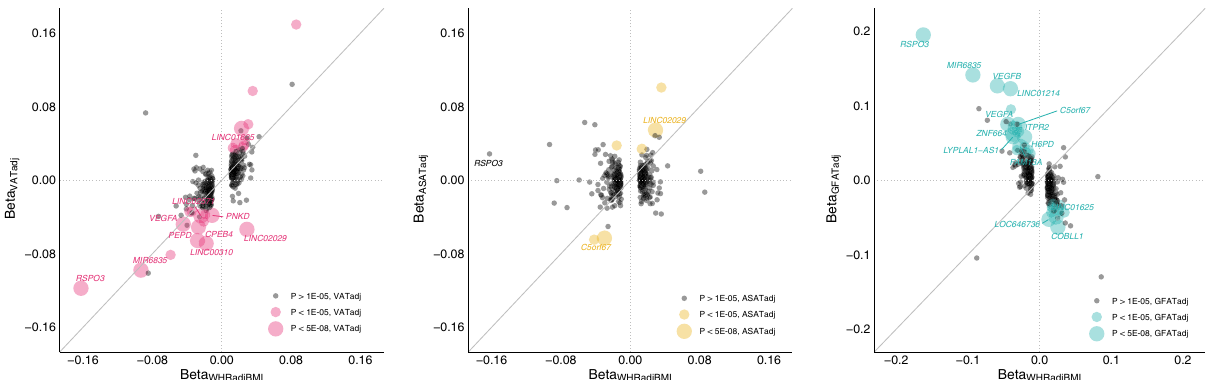
Fig. 4 Effects of previously identi fi ed WHRadjBMI loci on local adiposity traits. In total, 345 of the 346 index SNPs associated with WHRadjBMI in a recent meta-analysis from the GIANT consortium were available in the studied cohort 12 . Effect sizes of VATadj, ASATadj, and GFATadj are plotted against the effect size for WHRadjBMI as reported in the cited study (Supplementary Data 11). Betas and p values for VATadj, ASATadj, and GFATadj correspond to the BOLT-LMM association p values computed in this study for the 345 index